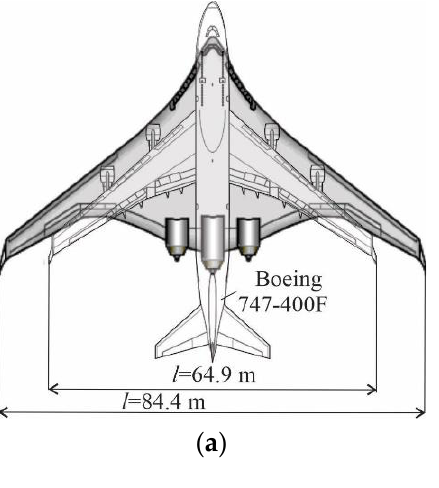
Figure 2. Existing and prospective aircraft with the same range and passenger capacity, but with greater fuel efficiency: ( a ) Boeing 747 and mixed wing-fuselage aircraft [19]; ( b ) A320neo and its two-fuselage counterpart [18].